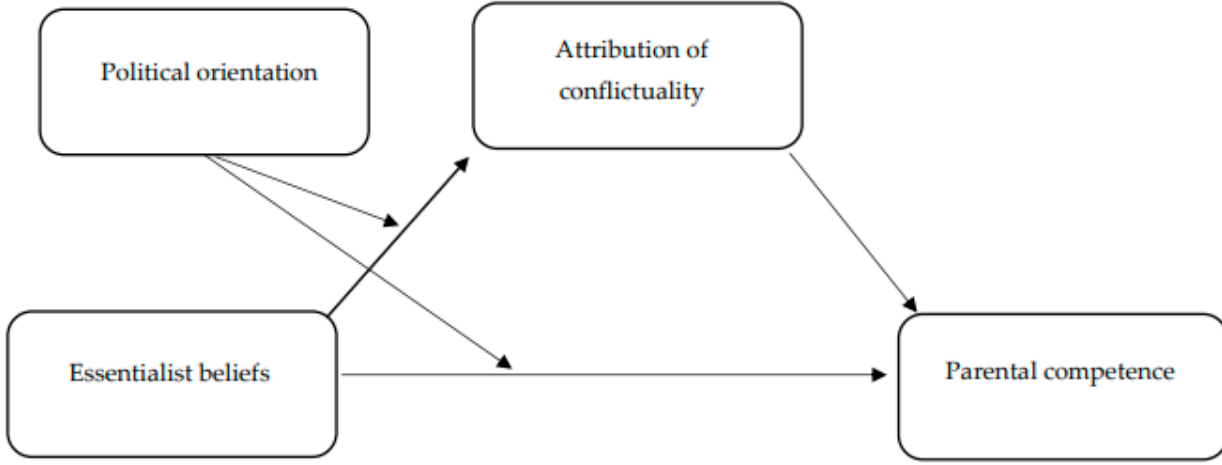
Figure 1. Theoretical model of the expectation of the evaluation of same-sex couples.